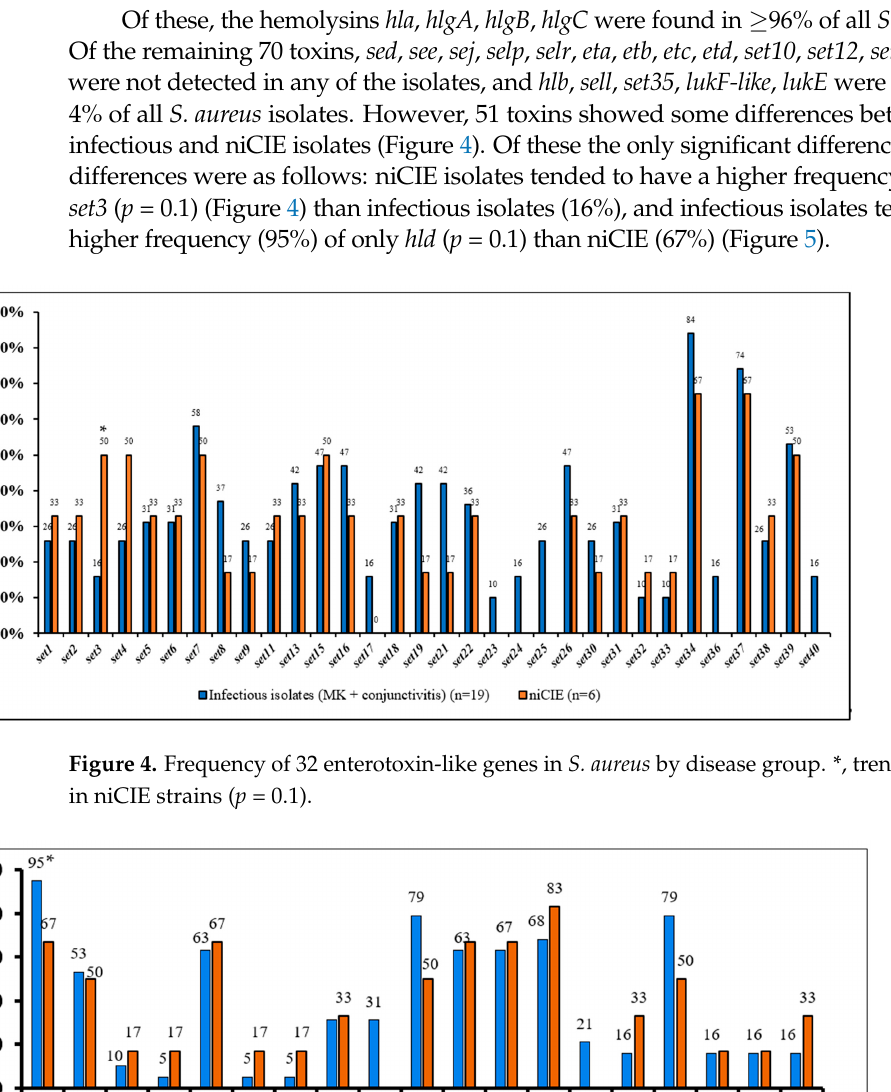
Figure 3. Possession of 7 virulence genes involved in immune evasion and type VII secretion system in S. aureus by disease group.